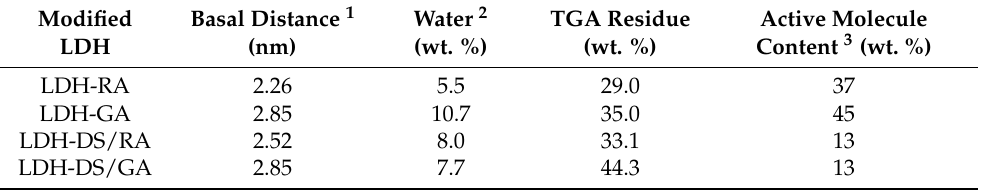
Table 1. Basal distance, water loss, TGA residue, and quantity of active molecules for modified